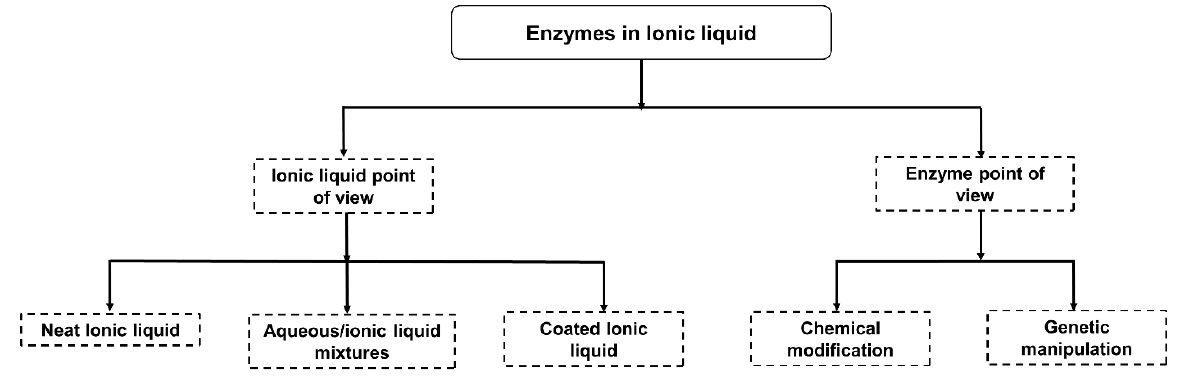
Figure 4. Different approaches to studying enzymes in ionic liquids.